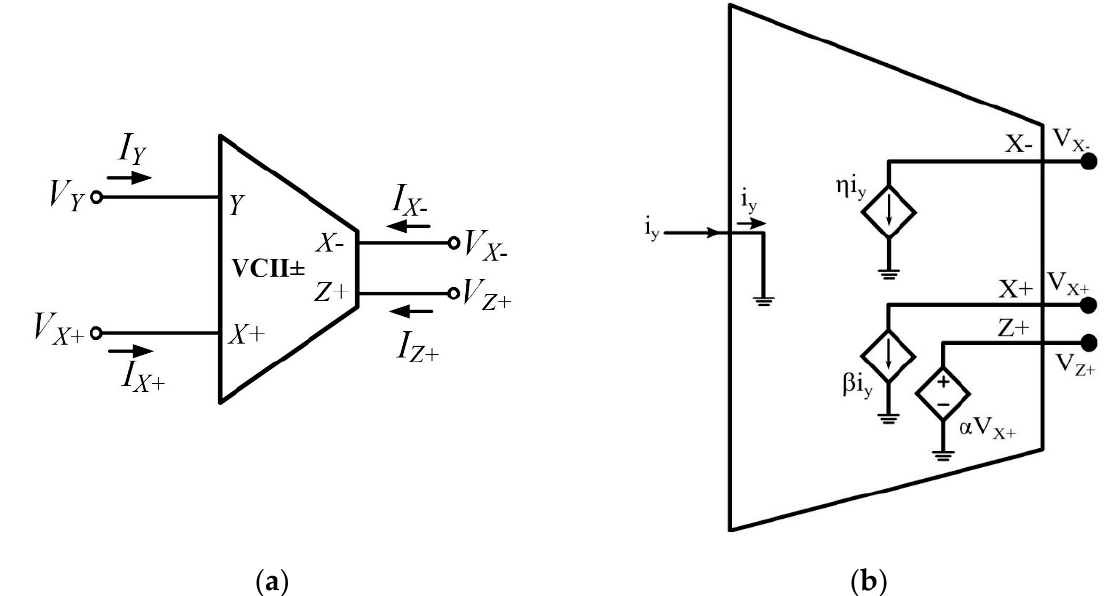
Figure 1. VCII± without Z − port: ( a ) symbolic presentation ( b ) internal structure. Figure 1. VCII ± without Z − port: ( a ) symbolic presentation ( b ) internal structure.